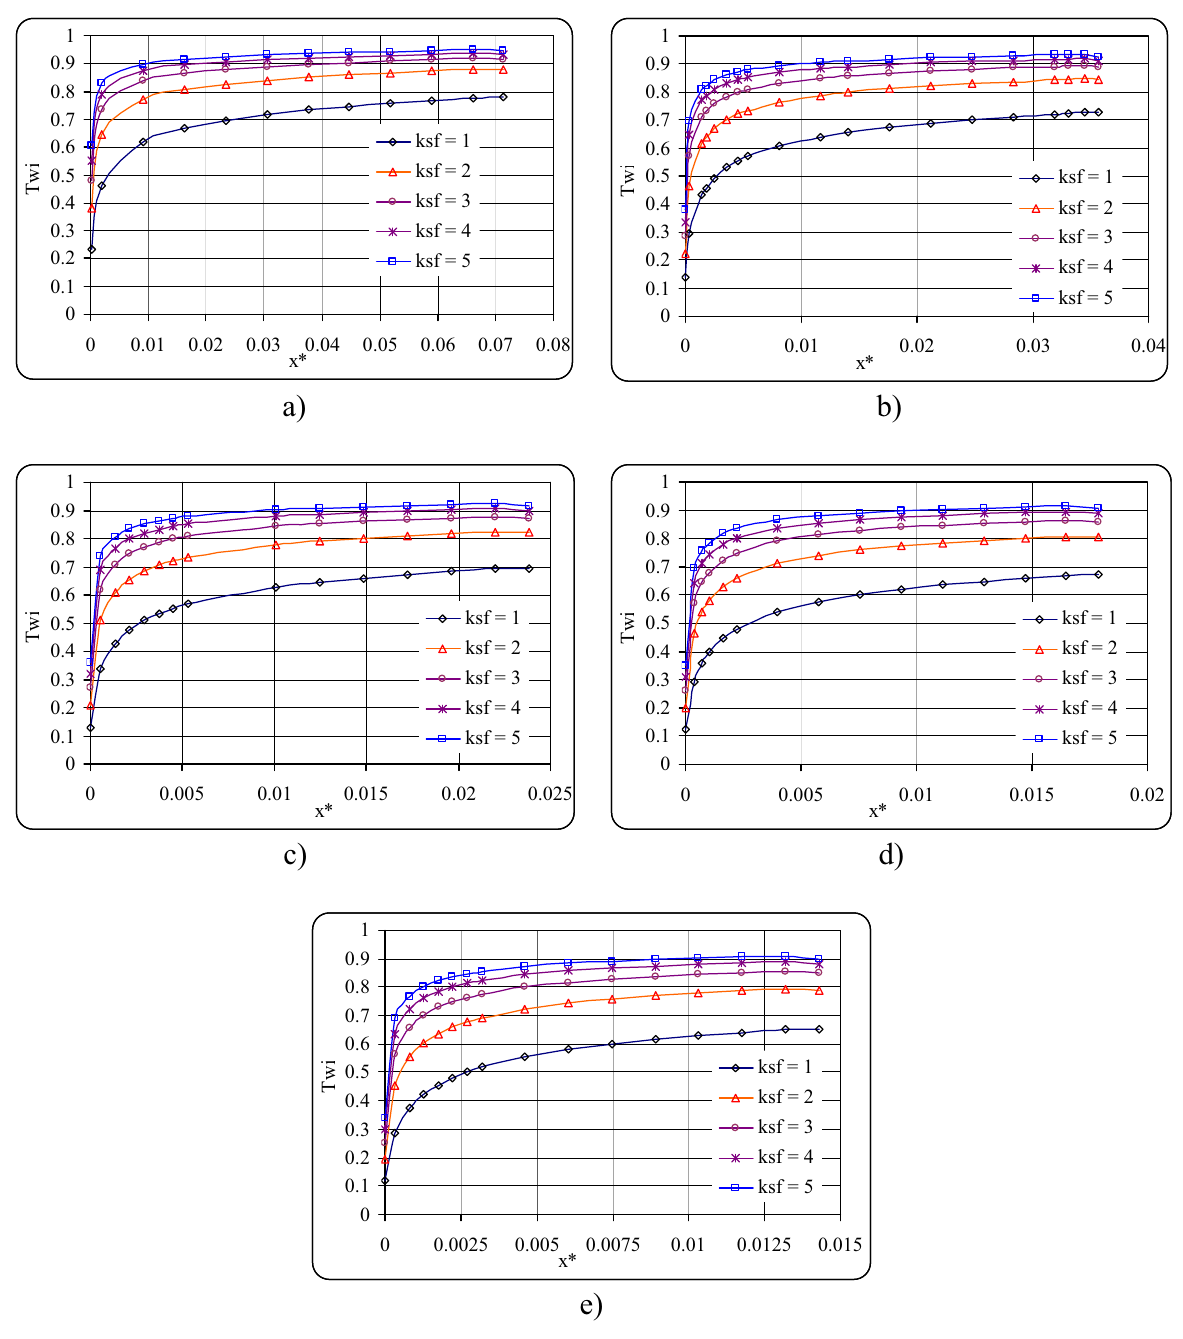
Figure 3: Relationship between dimensionless inside wall temperature vs dimensionless axial coordinate δ /R i = 0.25 and Pr = 7, with variable ksf ratio. ( a ) Re = 200, ( b ) Re = 400, ( c ) Re = 600, ( d ) Re = 800, and ( e ) Re =